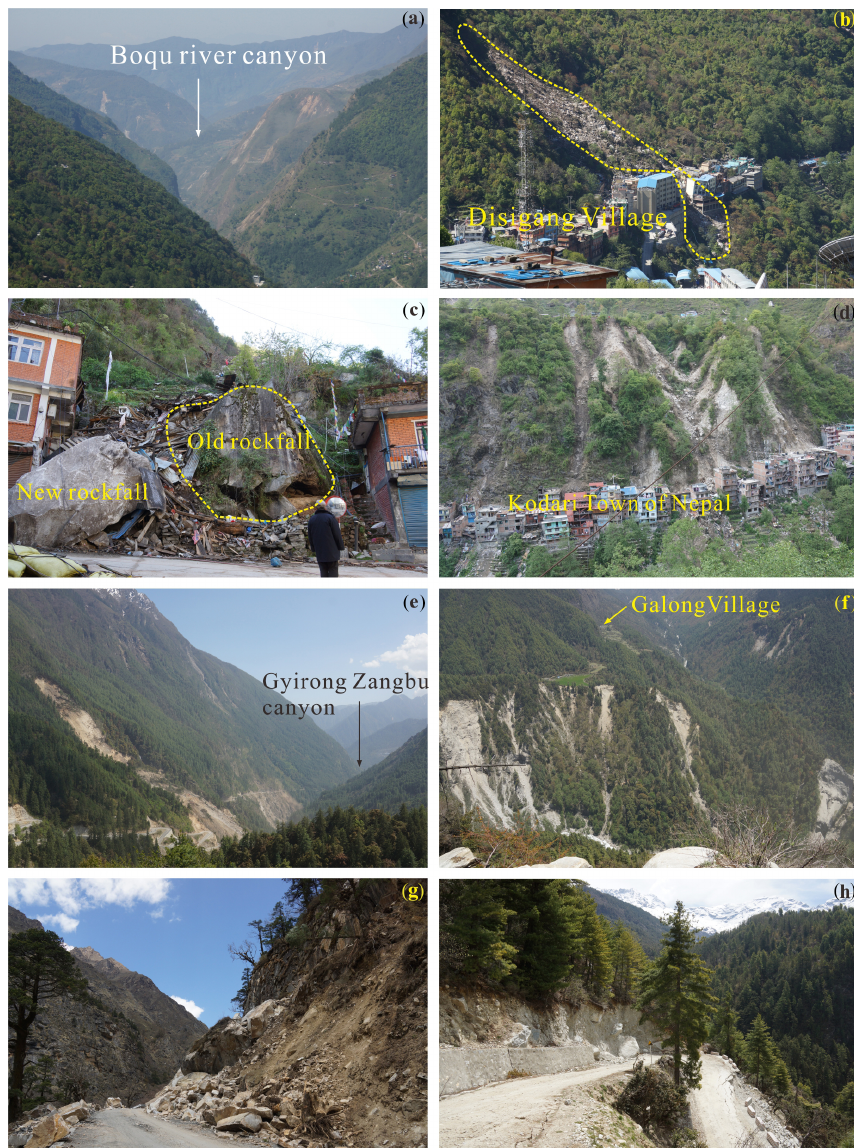
Figure 6. Geologic effects caused during the Nepal earthquake: (a) collapses in the Boqu valley; (b) collapse at Disigang Village in the Boqu valley (site 1, Fig. 5a); (c) new and old rockfalls at Disigang Village in the Boqu valley (site 1, Fig. 5a); (d) destroyed buildings in Kodari, Nepal, in the Boqu valley (site 1, Fig. 5a); (e) large landslide in Chongse Village in the Gyirong Zangbo valley (site 1, Fig. 5b); (f) collapses in Galong Village in the Gyirong Zangbo valley (site 7, Fig. 5b); (g) collapses along the highway from Gyirong County to Jilong Town in the Gyirong Zangbo valley (site 4, Fig. 5b); and (h) collapses and fissures along the highway from Jilong to Chongse Village in the Gyirong Zangbo valley (site 1, Fig.